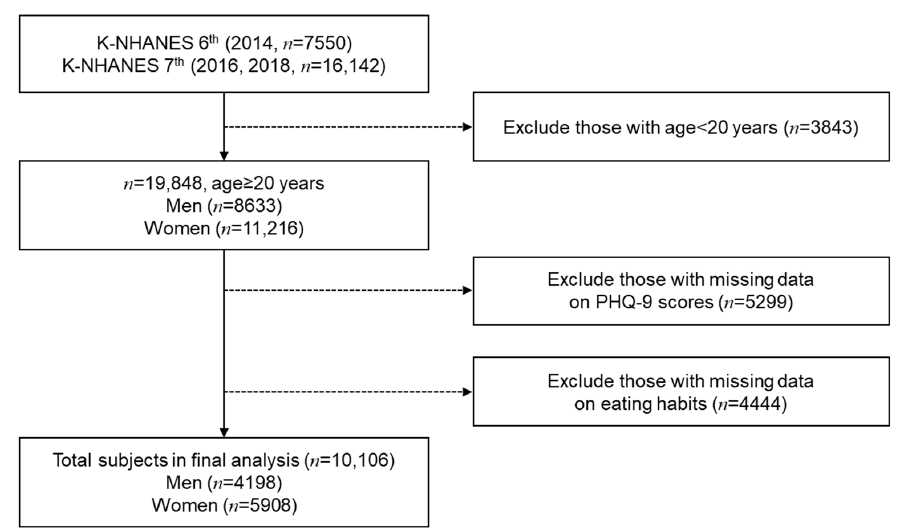
Figure 1. Flow diagram for selecting participants of the study.